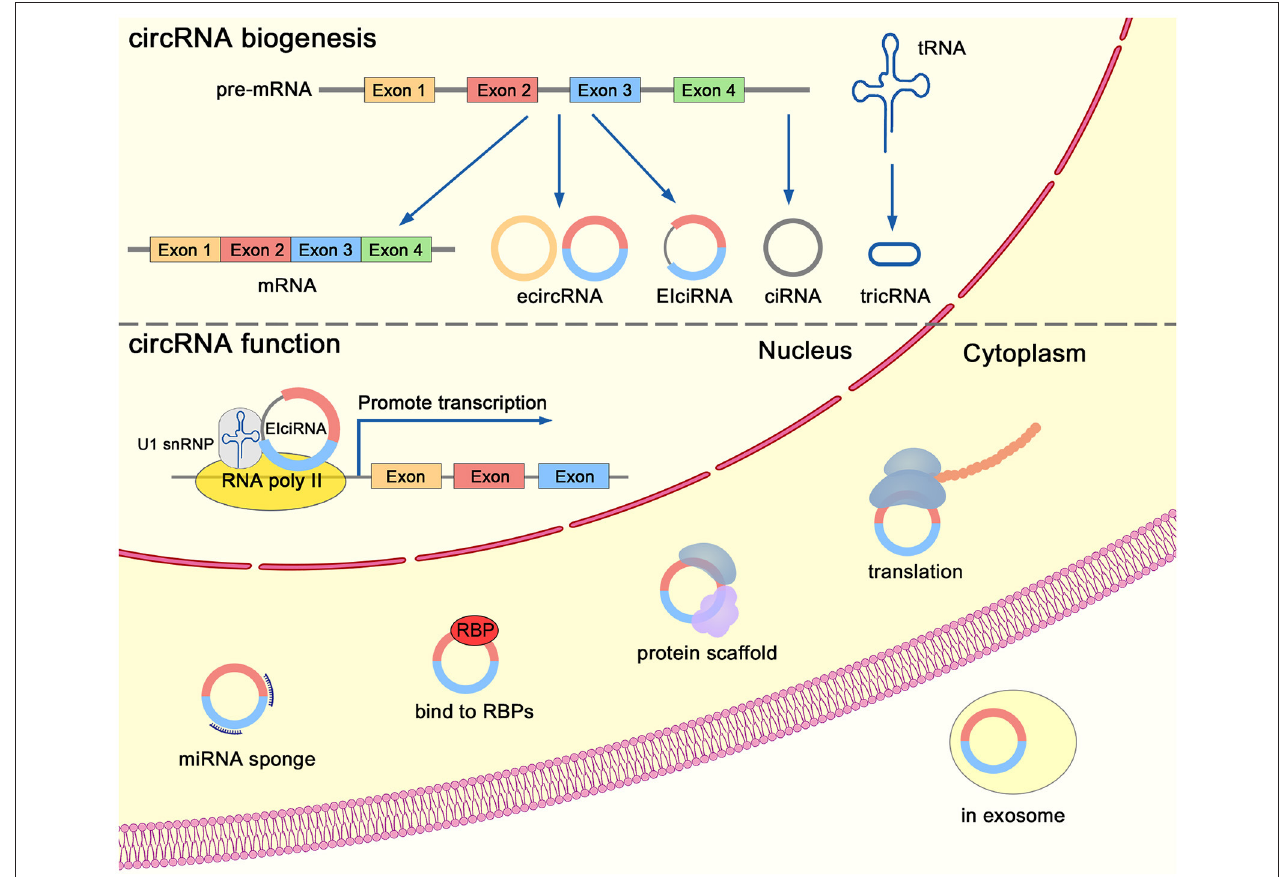
FIGURE 2 | Biogenesis and functions of